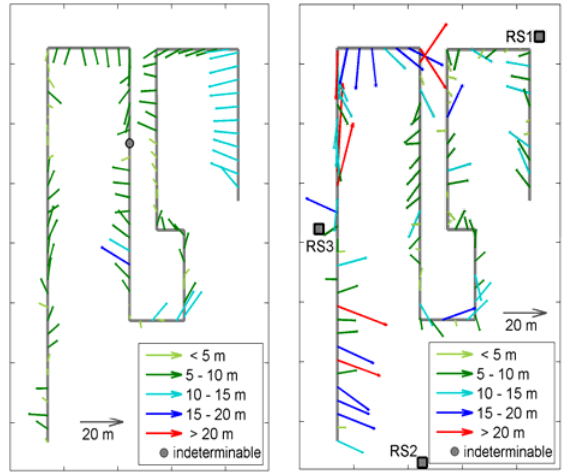
Figure 6. Deviations of the position estimates using the logarithmic one-slope (left) and the differential approach (right)